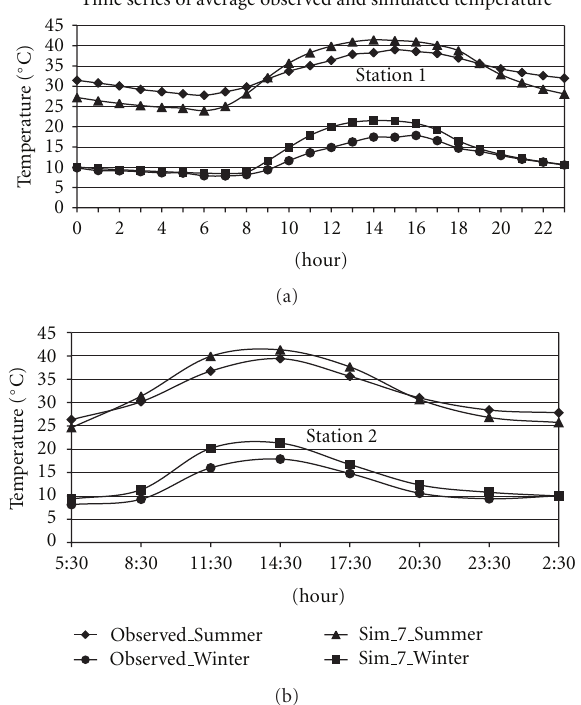
Figure 2: Comparison of average observed and simulated (simula- tion 7) surface temperature for station1 and station